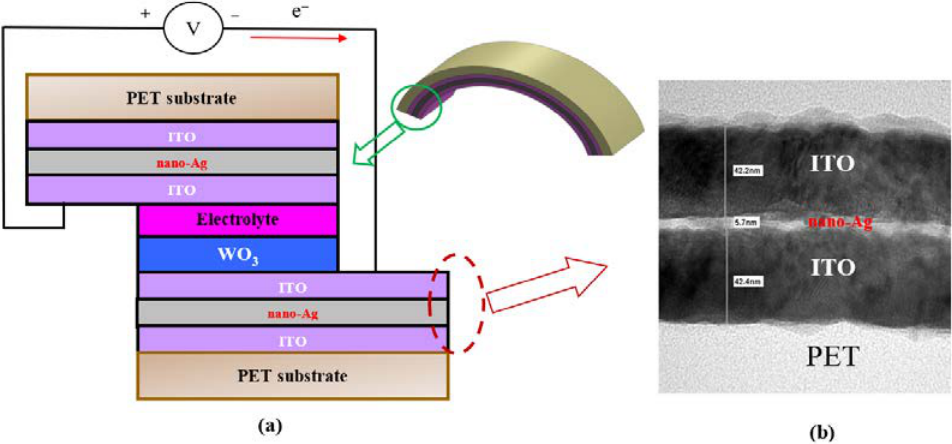
Figure 7. ( a ) Schematic cross-section of the developed ECD structures, and ( b ) the corresponding TEM image of the optimized ITO/nano-Ag/ITO layer (at Ag DC power of 0.2